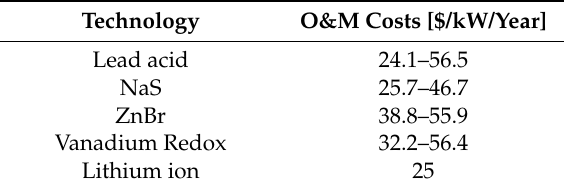
Table 2. Fixed operating and maintenance (O&M) Costs for Different BESS